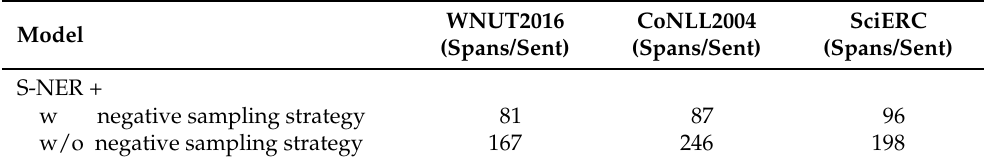
Table 4. Comparisons of negative span counts per training sentence under the conditions of using and not using the randomly sampling